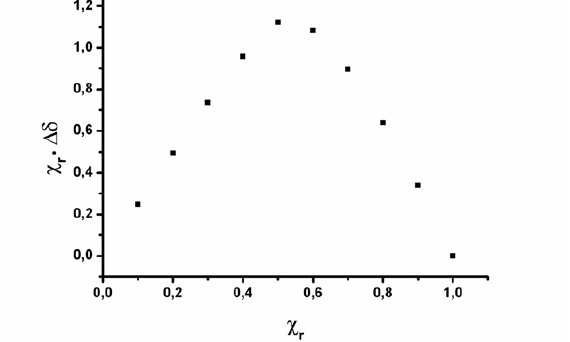
Figure 3. Job plot corresponding to the complexation of host III with (+)-biotin methyl ester 1 ([ III ] + [ 1 ] = 10